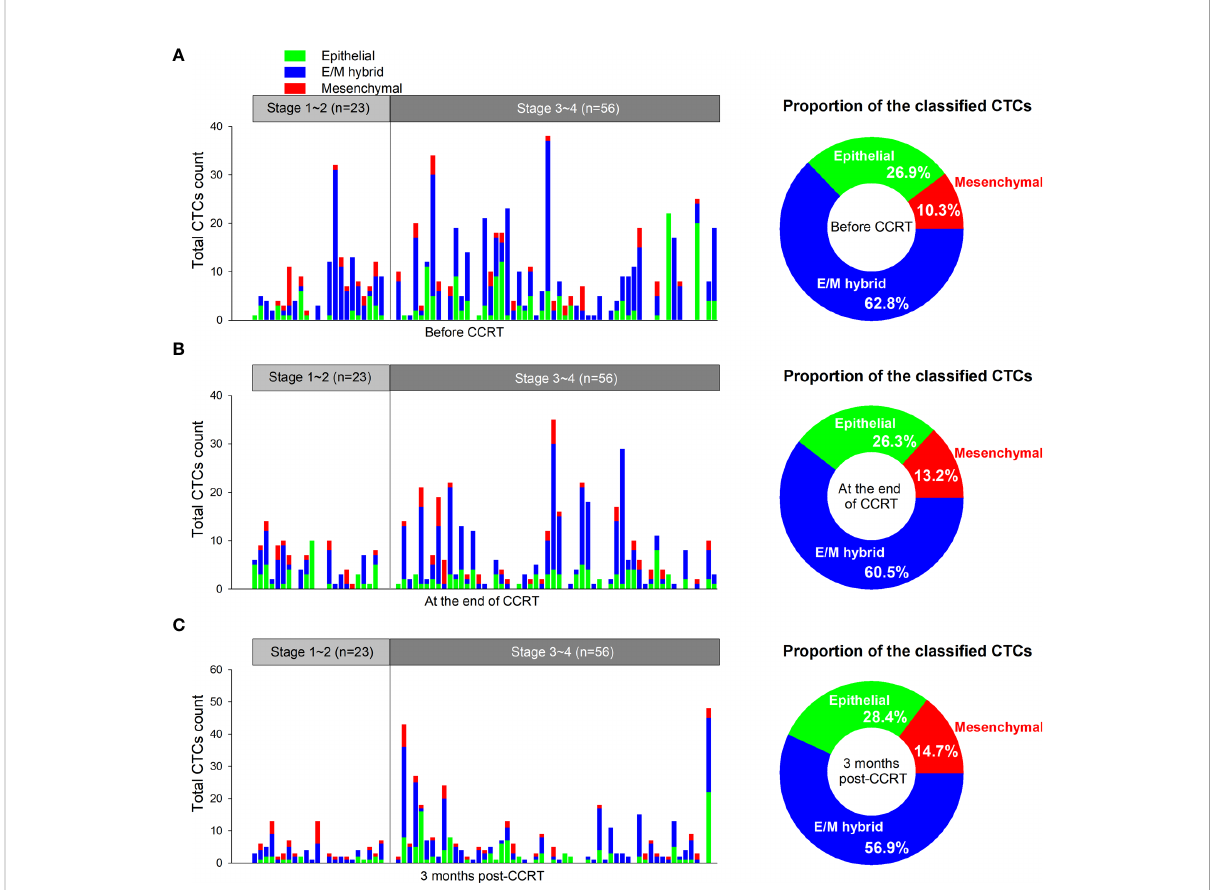
FIGURE 3 Numbers and distributions of circulating tumor cells (CTCs) before and after concurrent chemoradiotherapy (CCRT). (A) The numbers and distributions of the CTCs detected from each patient before CCRT are shown as tricolored bars. The proportions of phenotypically classi fi ed CTC subpopulations determined before CCRT are shown as a pie plot in the right panel. (B) Detection of CTCs at the end of CCRT. (C) Detection of CTCs at 3 months after CCRT. E/M,